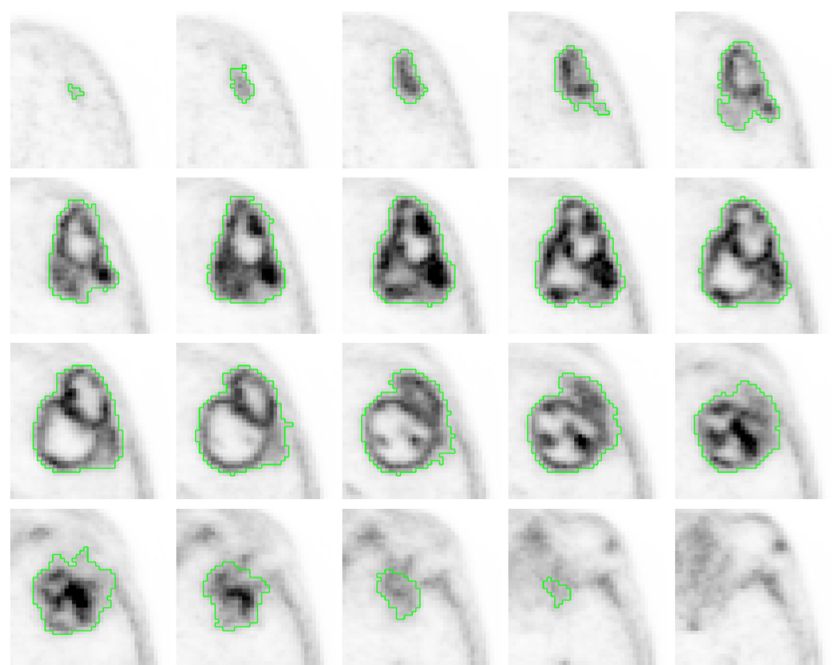
Figure 5. Axial 18 F-fluorocholine PET slices of a segmented IDH-wt high grade GBM of a 78-year-old male (patient 2) who underwent gross total resection and incomplete Stupp protocol. PFS and OS were 5 and 6 months, respectively. The visual analysis shows a heterogeneous radiotracer distribution (COV of 0.68), with high 18 F-fluorocholine activity in some peripherical locations (SUVmax of 5.46) with a SmCD of 19 mm.